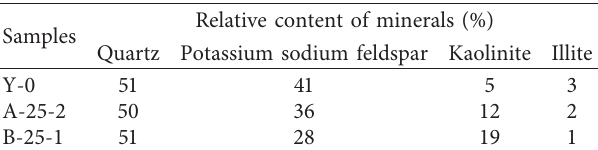
Figure 10: Evolution process of the lateral strain field of the feldspar sandstones (Group B) after the dry-wet cycles. (a) The curve of the representative points. (b) Destruction pattern. (c) Point 1. (d) Point 2. (e) Point 3. (f) Point Table 2: Relative content of the minerals in the feldspar sandstones of Groups A and B after the dry-wet cycles.